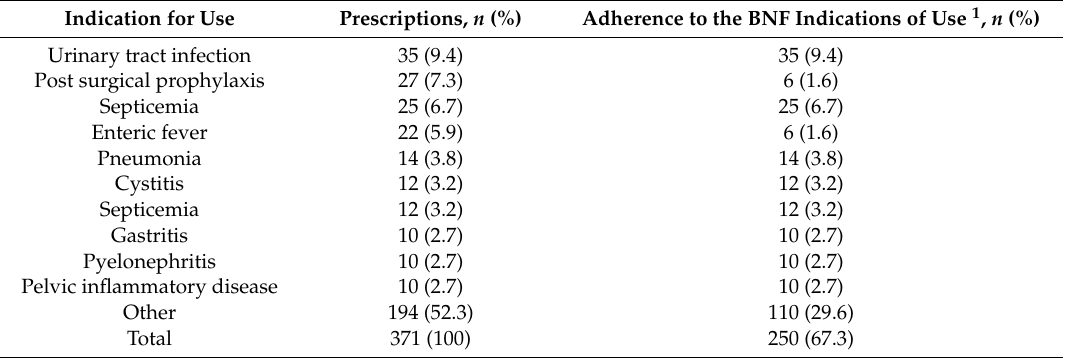
Table 2. Top 10 indications of use for levofloxacin in the studied prescriptions ( n = 371) and proportion adhering to the indications of use included in the British National Formulary